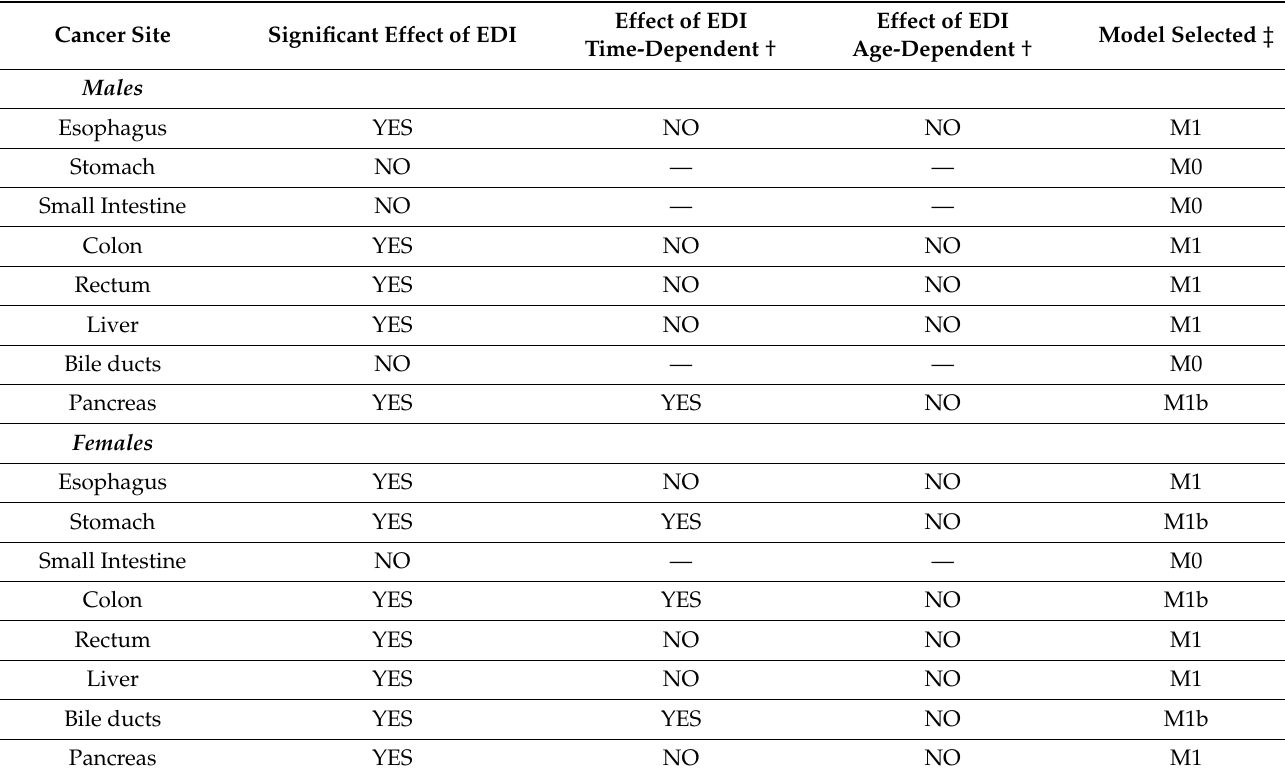
Table 2. Effect of deprivation assessed by EDI on net survival according to cancer site and sex, as assessed by selected flexible